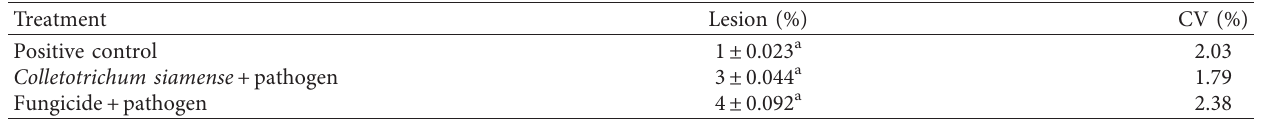
Figure 2: Guarana leaves under different treatments. (a) Negative control. (b) Positive control. (c) C. siamense +pathogen. (d) Fungi- cide+pathogen. The arrows indicate symptoms caused by the pathogen on the leaves 28 days after the start of the Table 1: Average lesion percentage in guarana seedlings 28 days after the start of the treatment.